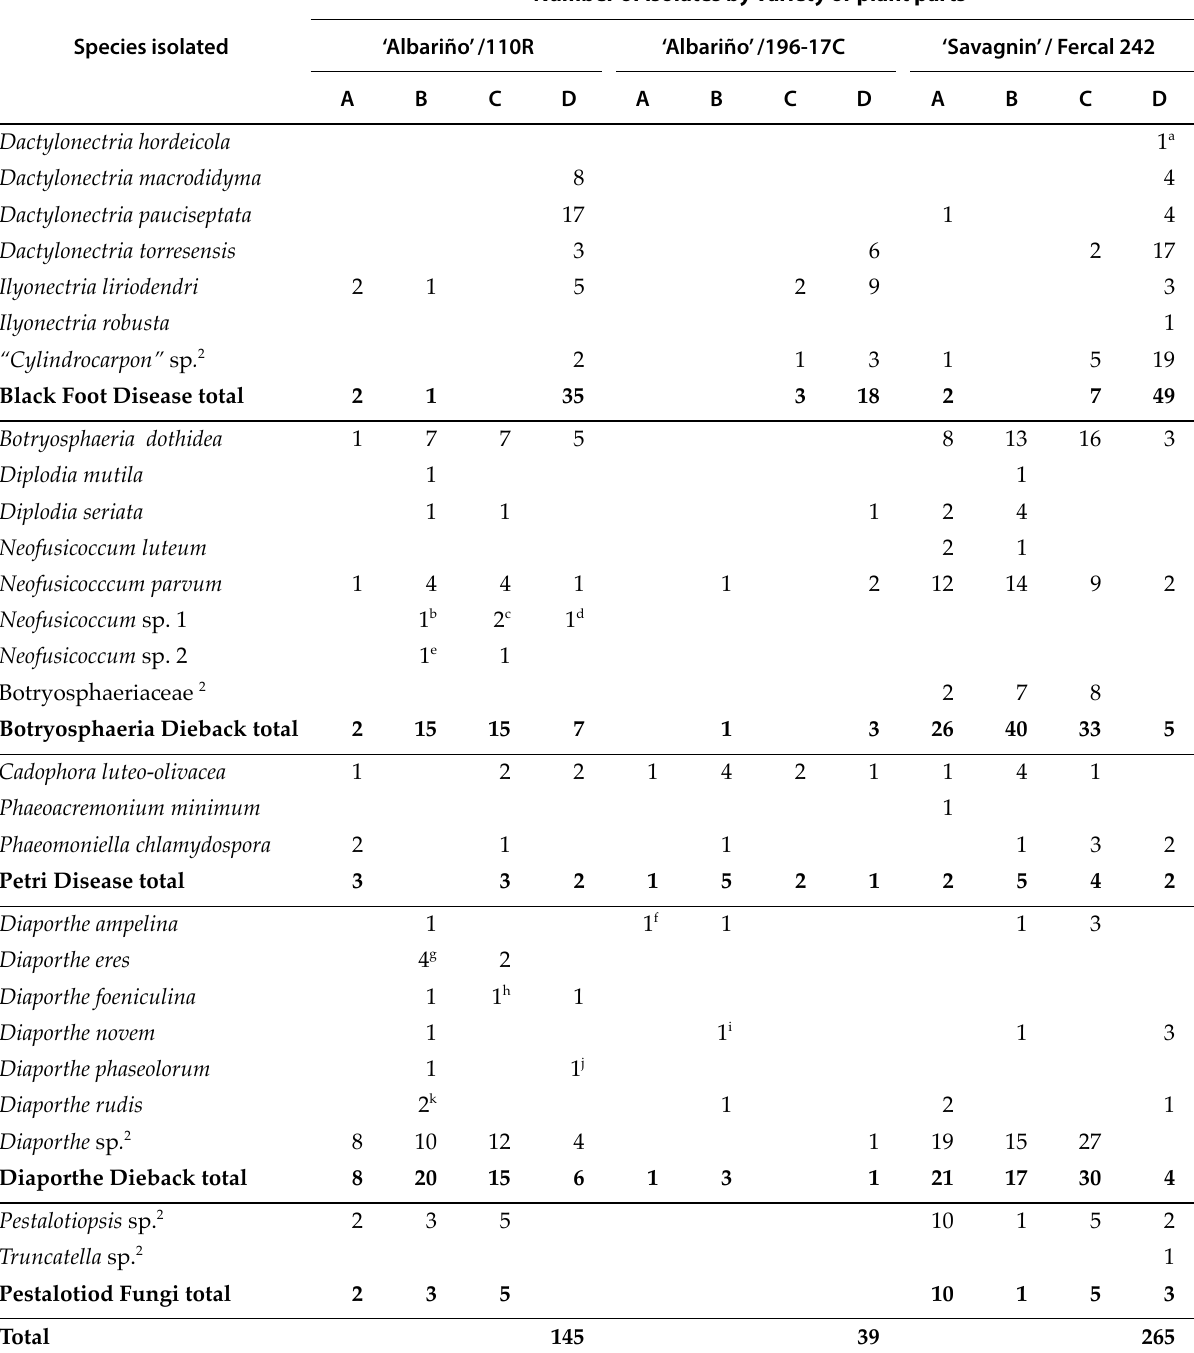
Table 4. Isolates of grapevine trunk disease fungi obtained from plants of grapevine varieties ‘Albariño’ or ‘Savagnin’ grafted on 110R, 196-17 or Fercal 242